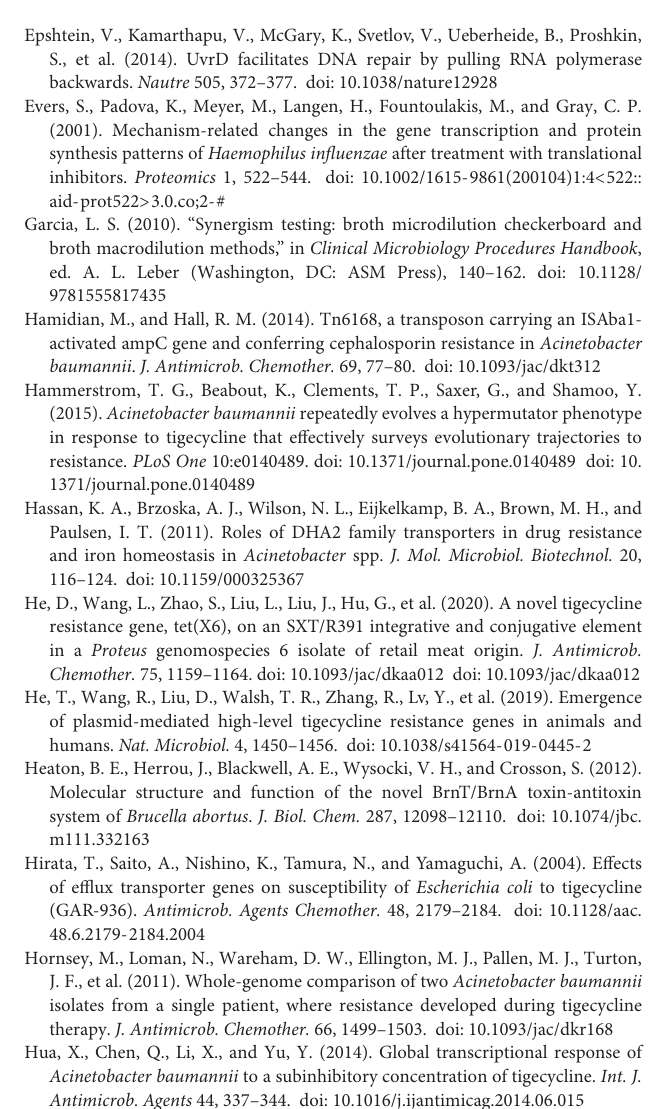
Supplementary Figure 2 | A global view of differential gene transcription induced by tigecycline. The circular map was based on the reference genome A. baumannii AB0057. From the outermost circle in, the circle 1 shows the ORFs on the plus strand of AB0057 chromosome, the circle 2 the ORFs on the minus strand, the